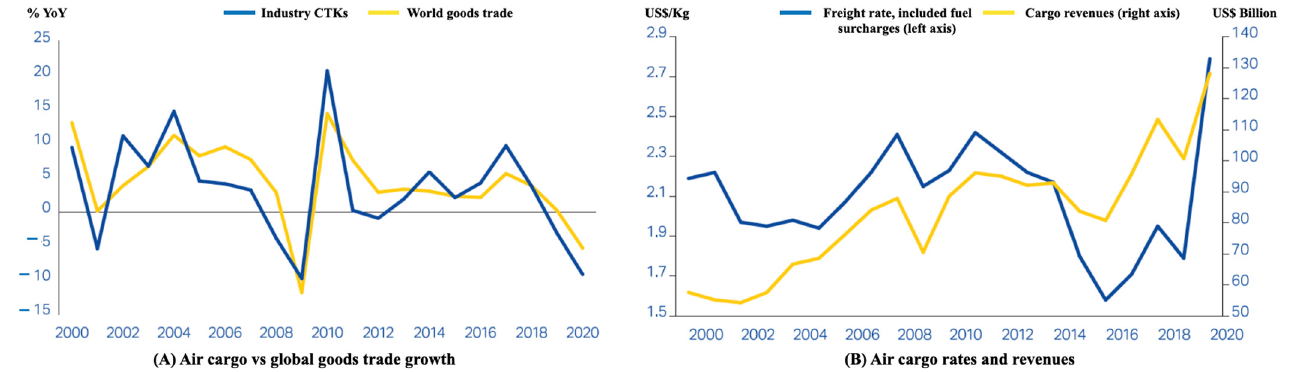
Figure 7. The initial impact of the pandemic on air cargo, rates, and revenues from 2000 to 2020. Source: Author’s own elaboration from IATA figures [101].